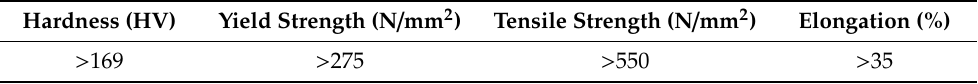
Table 2. Mechanical properties of SUS304 stainless steel plate.